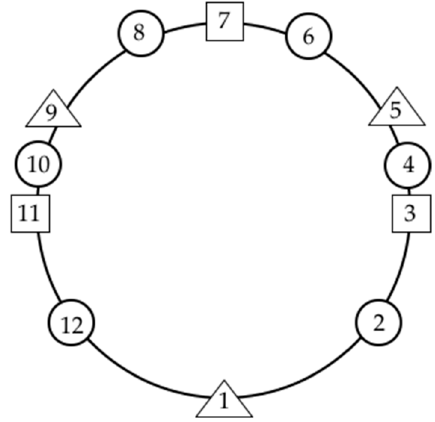
Figure 10. Schematic SelfA rotary encoder of sensor heads setup. The first set is the triangle NH of 3, the second set is the square NH of 4, and the third set is the circle NH of 7 [10].